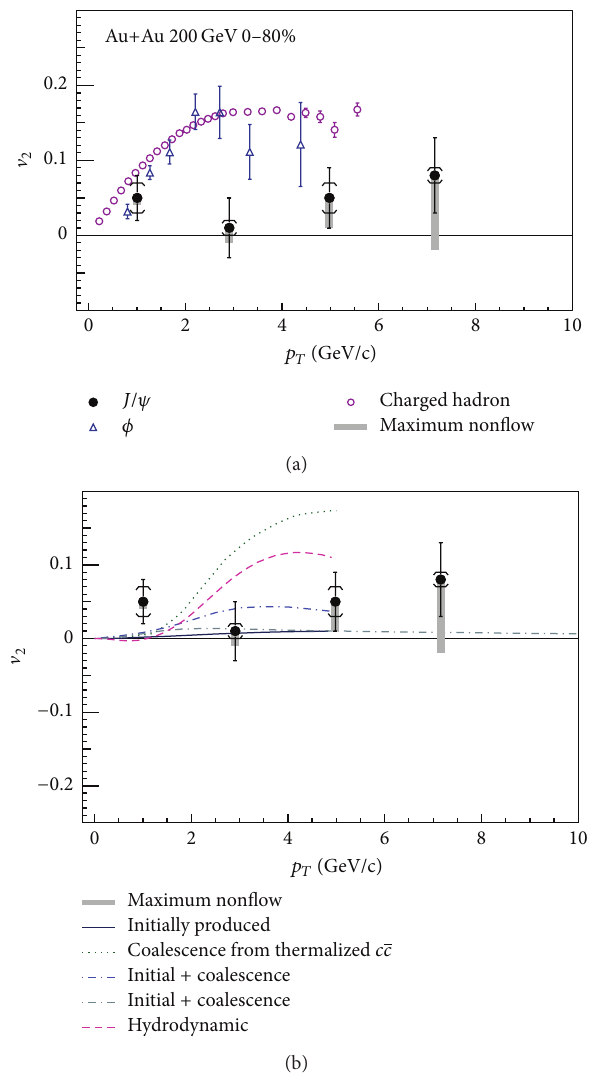
Figure 10: Elliptic flow of for 𝐽/𝜓 particles at mid-rapidity in 0– 80% min-bias Au+Au events at √𝑠 NN = 200 GeV [50] compared with charged hadrons [51] and the 𝜙 meson [52] (a) and theoretical calculations [53–56]